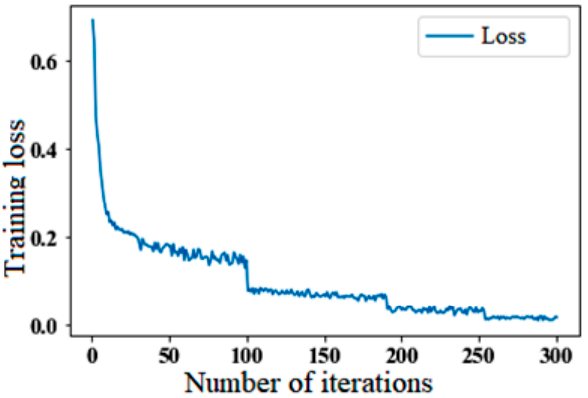
Figure 7. SAE model iteration process.